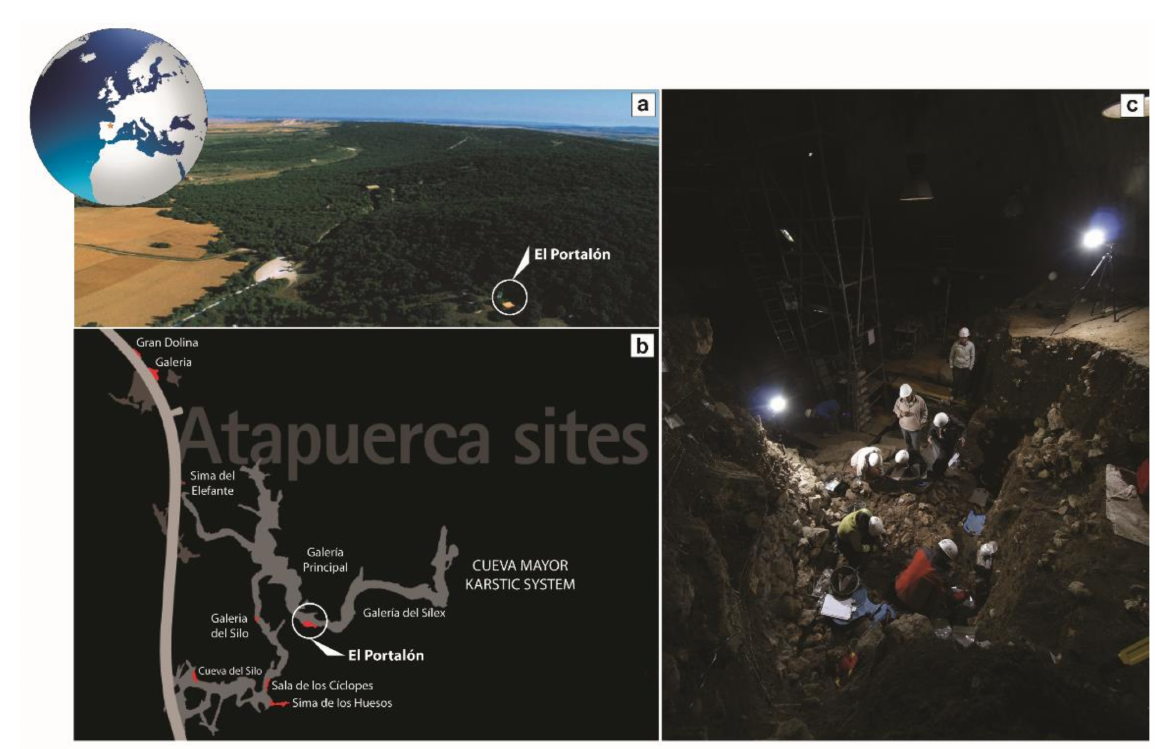
Figure 1. Location of El Portal ó n de Cueva Mayor archaeological site. ( a ) Location of the site in the Sierra de Atapuerca; ( b ) location of the site at the entrance of the Cueva Mayor-Cueva del Silo karstic system (plan view), with the latter containing numerous Lower Pleistocene to Holocene archaeo-paleontological sites (in red); ( c ) general view of the works during the excavation of the early Chalcolithic funerary tumulus (ca. 5000 yr cal